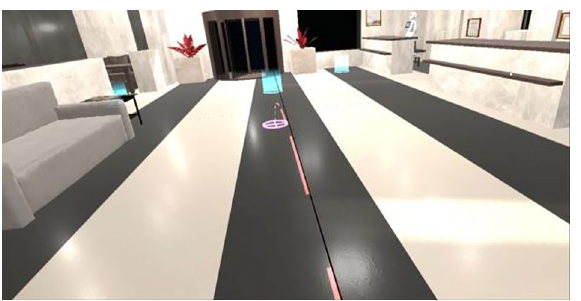
Figure 2. Virtual hotel lobby where the hotel concierge interacts with the